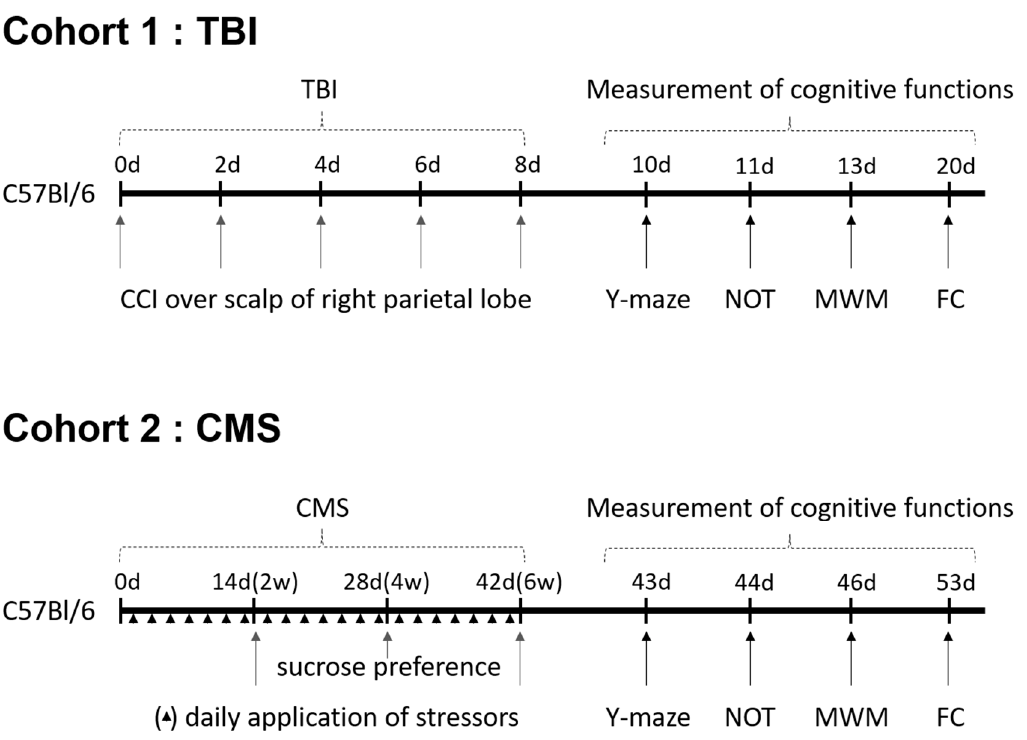
Figure 5. Experimental outline of mild cognitive impairment mice models induced by TBI (Cohort 1) and CMS (Cohort 2). TBI: Traumatic brain injury, CCI: Controlled cortical impact, Y-maze: Y shaped maze test, NOT: Novel object test, MWM: Morris water maze, FC: Fear conditioning, CMS: Chronic mild stress.